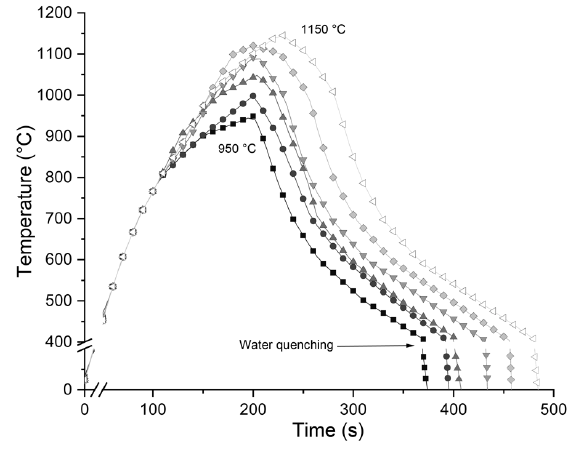
Figure 4. Thermal cycles of the Gleeble annealing simulations (peak temperatures 950–1150 °C).